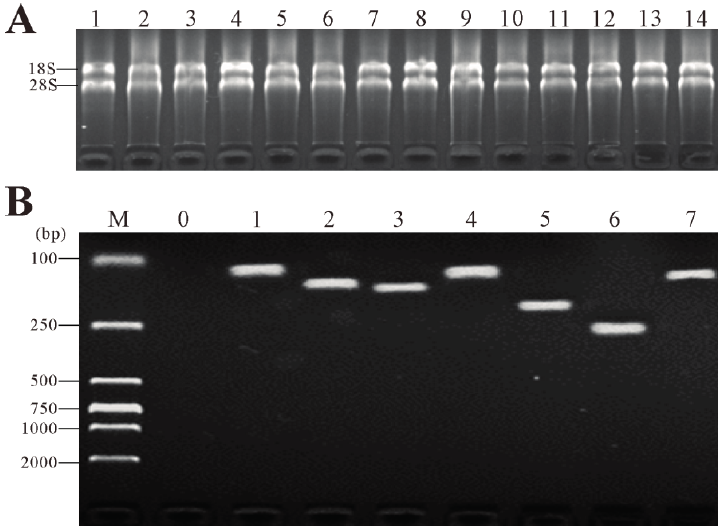
Figure 1. Agarose gel electrophoresis of total RNA and PCR amplification of the candidate reference genes and target gene using synthesized cDNA as templates. ( A ) Total RNA extracted from the spleen at 0w (the zero day before vaccination), 1w (1 week post-vaccination, the same below), 2w, 3w, 4w, C24h (24 h post-challenge), C2w (2 weeks